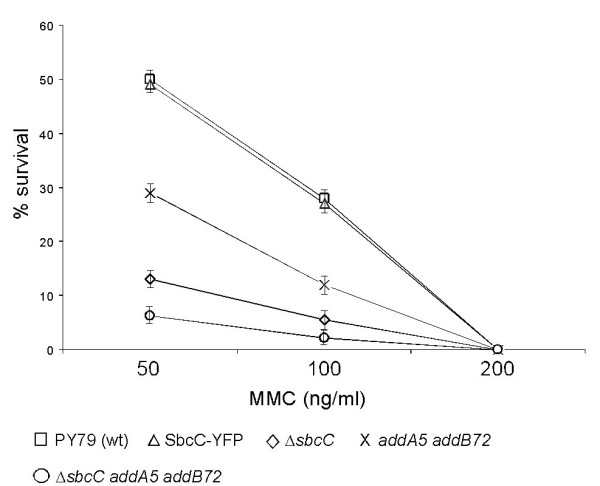
Survival of Bacillus subtilis wild type or of mutant cells after addition of different doses of MMC for 20 min. The strains used are indicated by the relevant genotype. At least three independent experiments were performed, bars denote standard deviations.